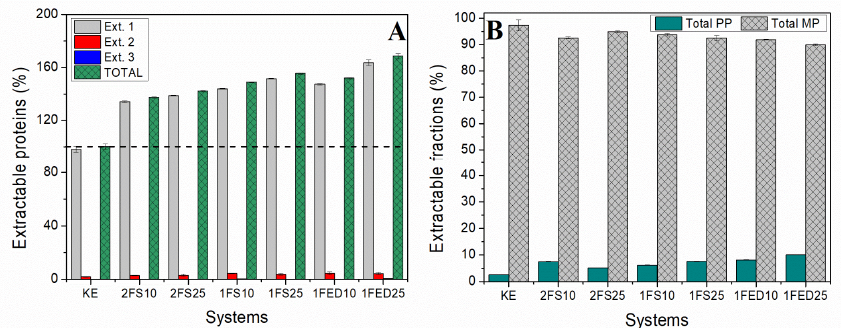
Figure 8. ( A ) Extractable proteins from serial extractions and ( B ) total polymeric (PP) and monomeric (MP) extractable fractions from HPLC and normalized to the KE sample for keratin (KE) and keratin functionalized in one (1) ‐ or two (2) ‐ stages, with SA (S) or EDTAD (ED) at 10% and 25%.